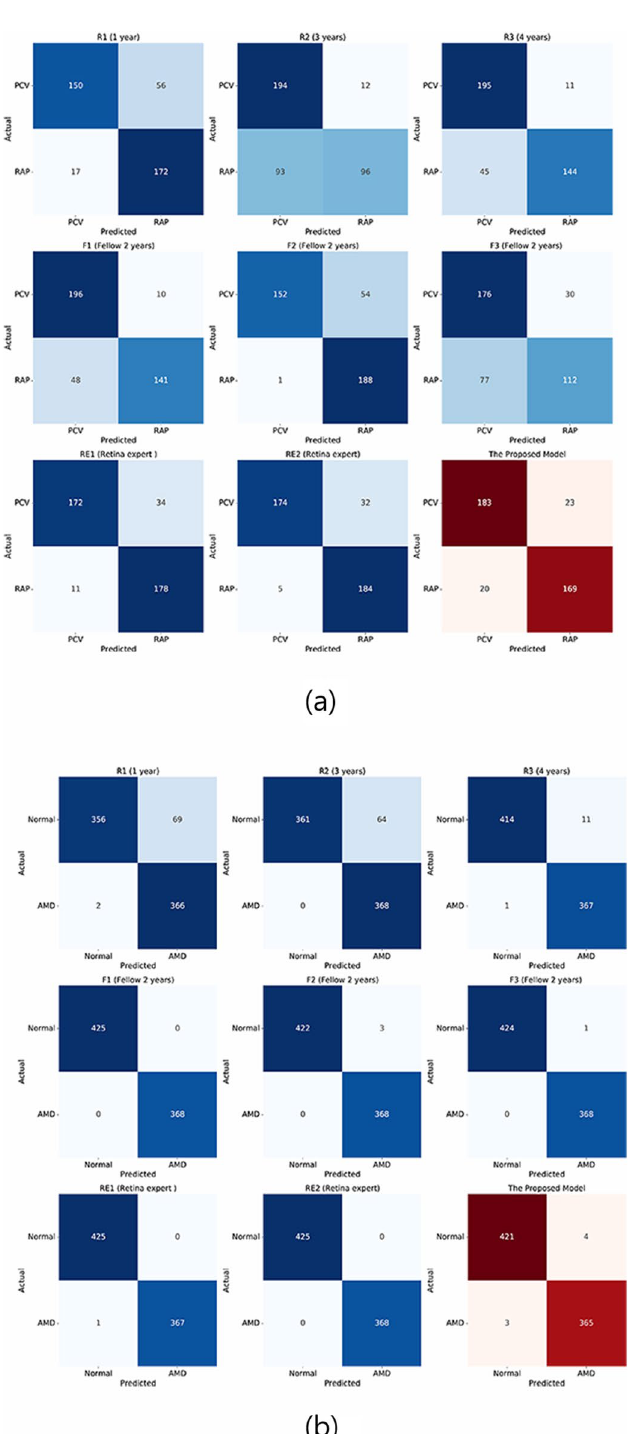
Figure 2. Confusion matrixes of the eight ophthalmologists and the proposed model. ( a ) Normal retina vs. neovascular AMD. Confusion matrixes showing how the eight ophthalmologists and the model classified the test set. Five of the eight ophthalmologists have an accuracy of more than 99%, whereas the model shows 99.1% accuracy. ( b ) Confusion matrixes of distinguishing between PCV and RAP cases. The average accuracy of the eight ophthalmologists is 83.0%, and our proposed model has an accuracy score of 89.1%. R1, R2, and R3 denote ophthalmology residents with 1 year, 3 years, and 4 years of experience, respectively. F1, F2, and F3 denote retina fellows with 2 years of experience. RE1 and RE2 refer to retina experts with more than 10 years of experience at a retina